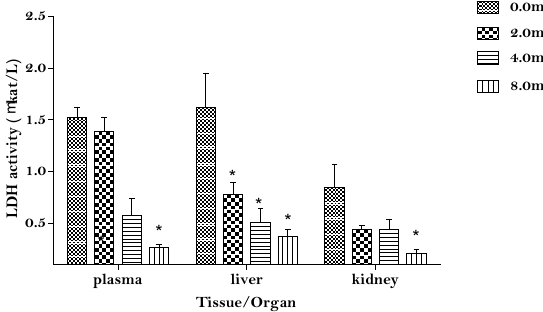
Fig. 1. Creatine kinase activity in Clarias gariepinus exposed to sublethal concentrations of chromium after 7days exposure pe- riod. Each column represents the mean value and vertical bars indicate the standard error of the means. Asterisk represents sig- nificant difference between the control and experimental group at 0.05 level